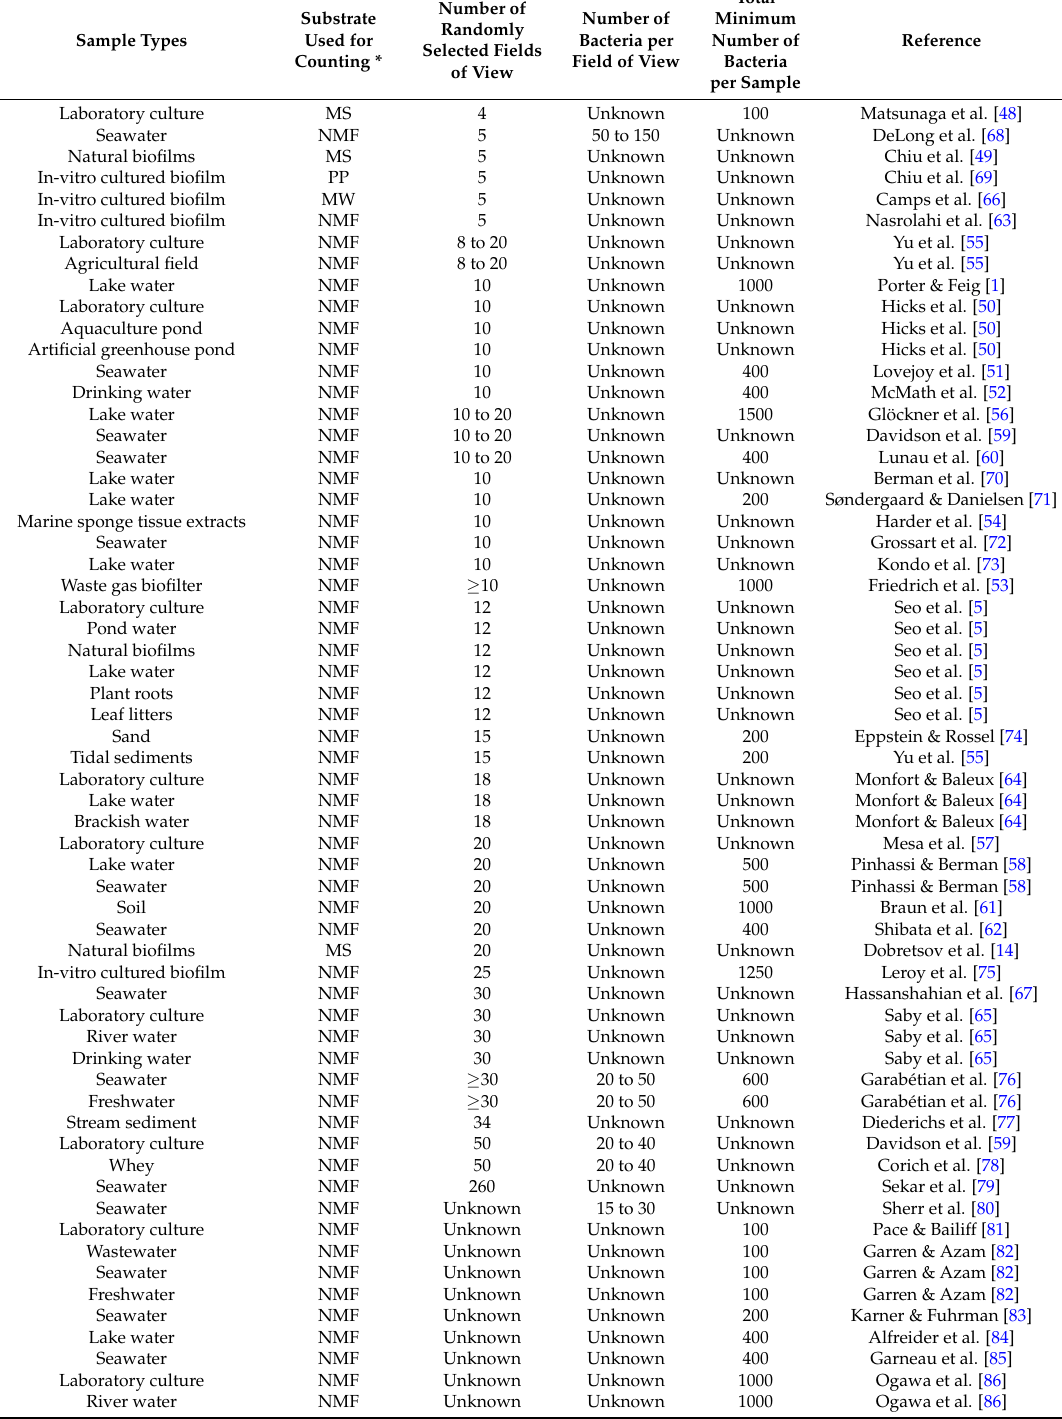
Table A1. Review of publications citing the approach of selecting random fields of view to count bacterial cells stained with 4 (cid:48) 6-diamidino-2-phenylindole (DAPI) using epifluorescence